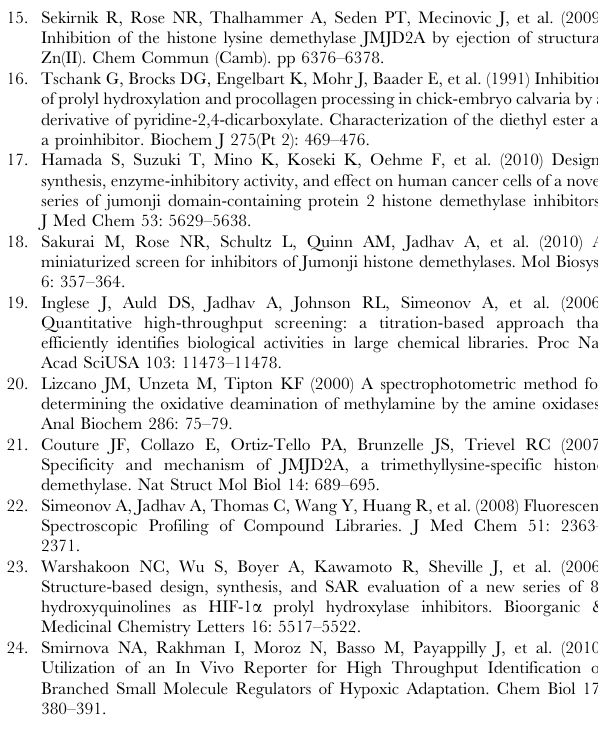
Figure S3 Cell-based demethylation assay. (A) Quantita- tion of H3K9me3 levels. 5-Carboxy-8-hydroxyquinoline (SID 85736331) treatments were at 20 m M, 50 m M, 100 m M, 200 m M,